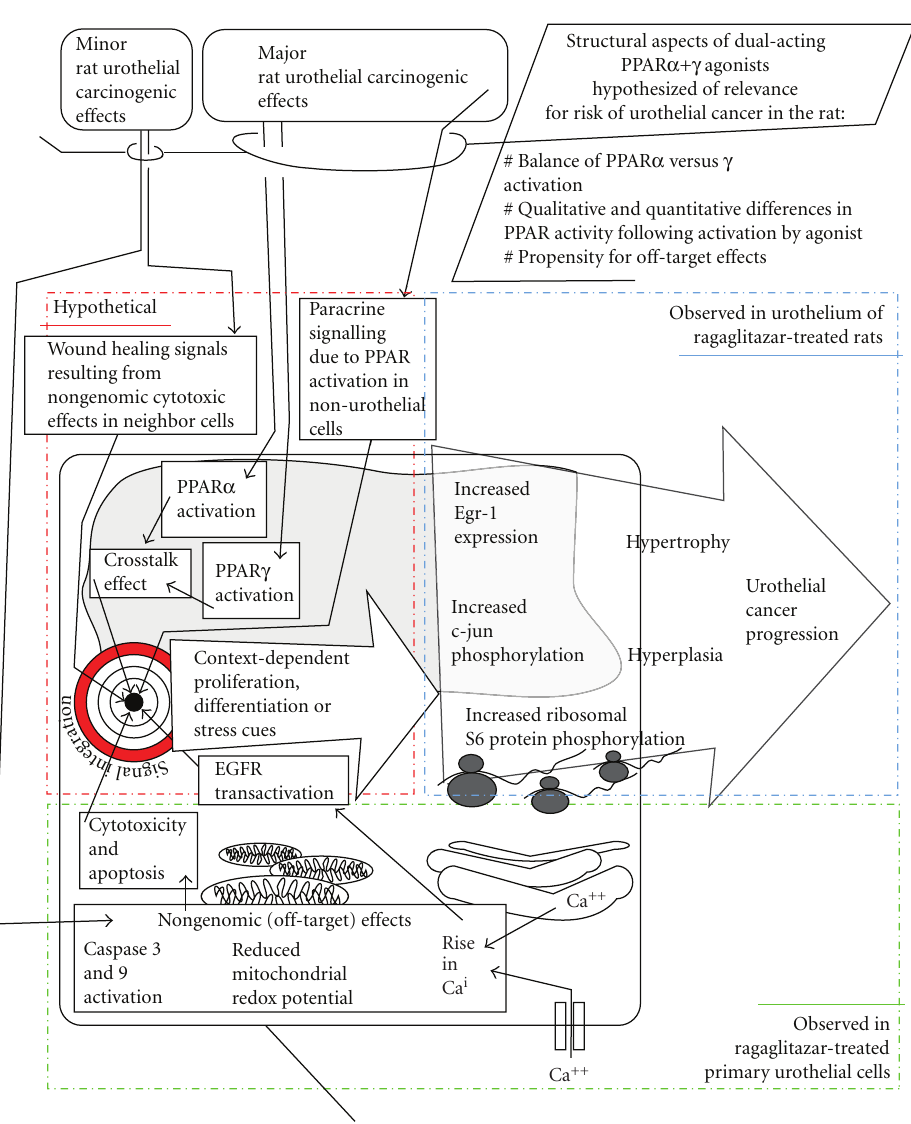
Figure 3: Current mode-of-action hypothesis for the carcinogenic e ff ect of dual-acting PPAR α + γ agonists in the rat urothelium. To explain the carcinogenicity of dual-acting PPAR α + γ agonists in the rat urothelium, we favor a multifactorial mode-of-action (MOA) hypothesis, compatible with the observation that PPAR agonists can cause diametrally opposite biological e ff ects (mitogenesis as well as cytotoxicity in vitro, carcinogenicity as well as tumour inhibition in vivo) depending on context (species, PPAR activation profile of agonist, agonist dose, cell type as well as PPAR expression, etc.) [2, 4–6, 8, 33–36, 62, 106, 107]. (The shown MOA hypothesis is based on previously published ragaglitazar data [18, 28–30, 61], but may be applicable to other dual-acting agonists (Table 1) [8, 31]. The shown MOA hypothesis is applicable to rats only due to the known profound species di ff erences in PPAR function [26, 32]. Bladder cancer was seen in SD, Wistar, and Fischer rats of both sexes [8, 29], but the shown MOA hypothesis may nevertheless be rat strain dependent due to rodent strain di ff erences in PPAR function [10]. The shown MOA hypothesis is compatible with gender di ff erences, due to gender di ff erences in PPAR expression and function [108–113], and does not assume urinary excretion of the PPAR agonist